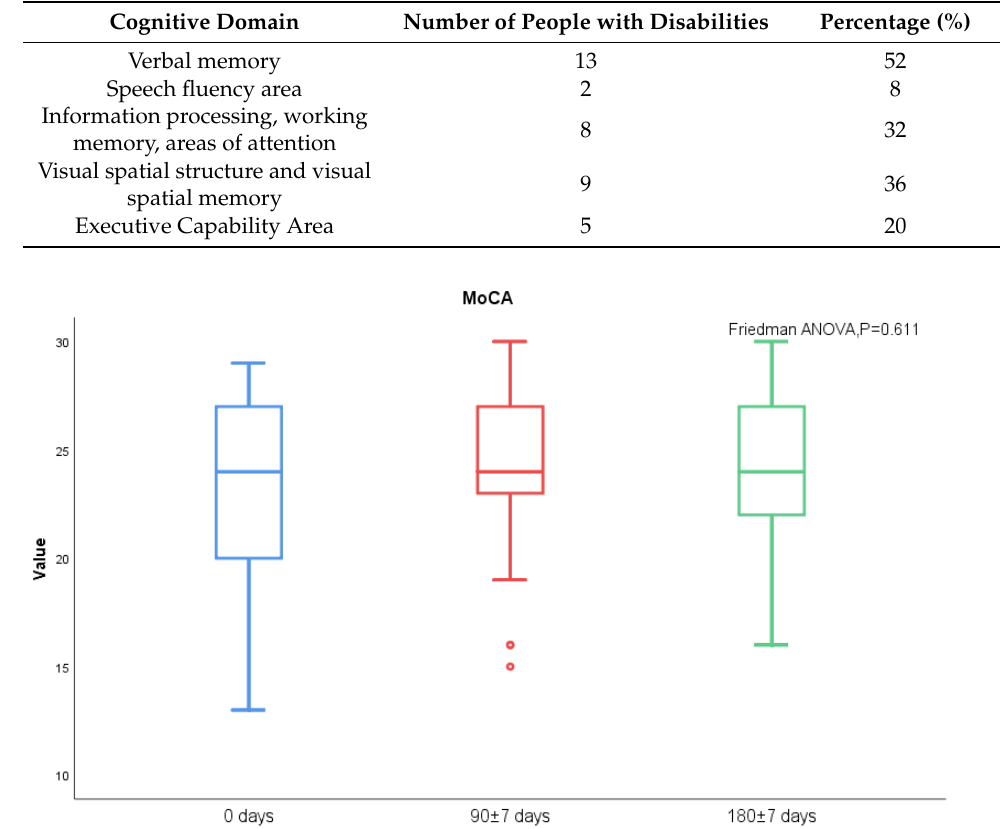
Figure 3. AQP-4 antibody titers between acute and chronic NMOSD.